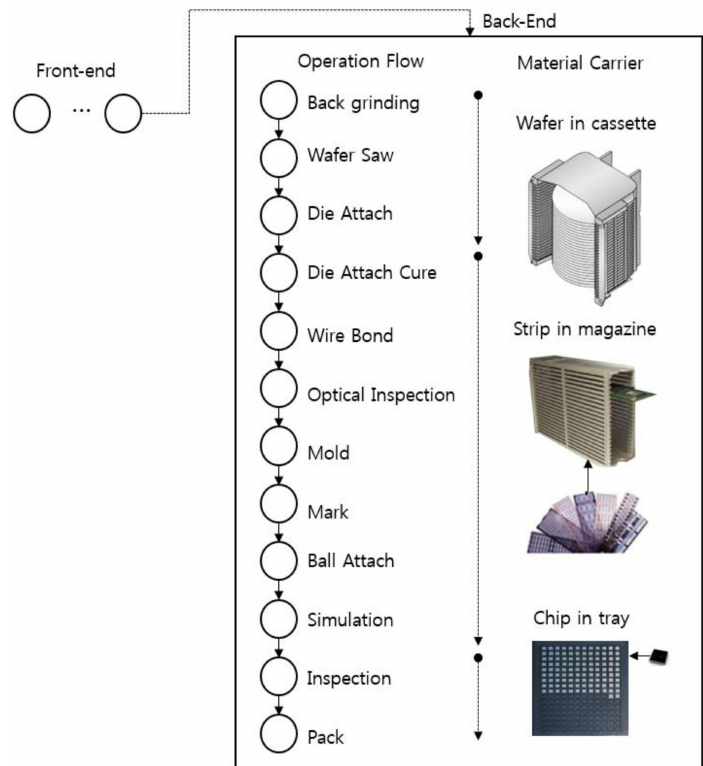
Figure 1. Semiconductor back-end